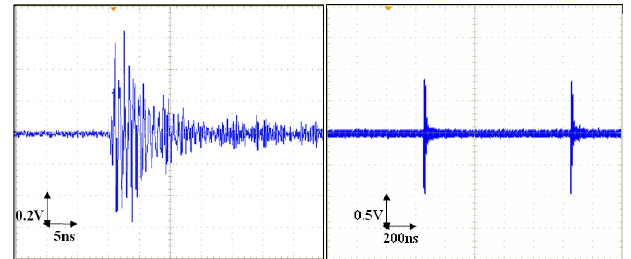
FIG. 10. (Color) Signal from one